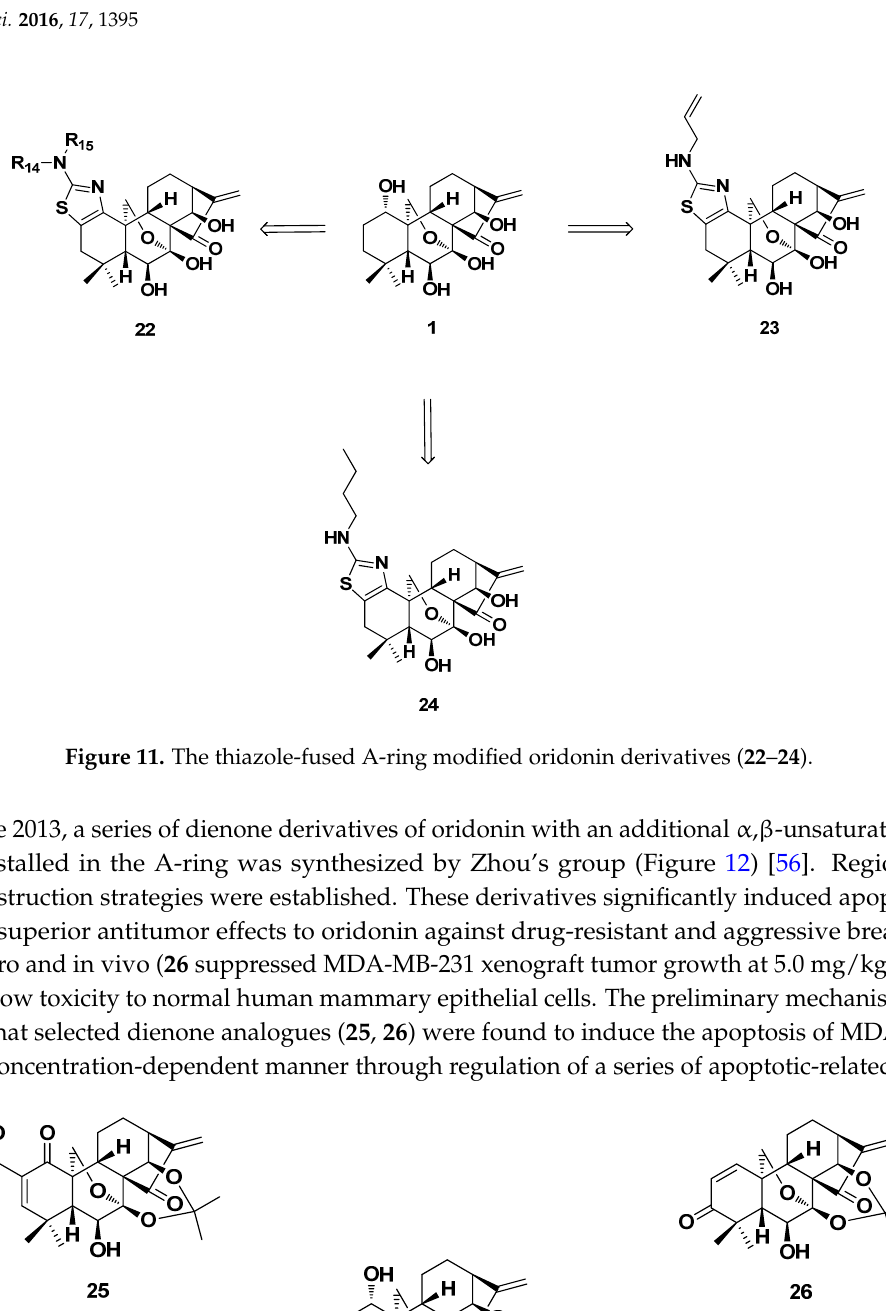
Figure 12. The dienone derivatives ( 25 – 28 ) of oridonin with the α , β -unsaturated ketone system in the A-ring.